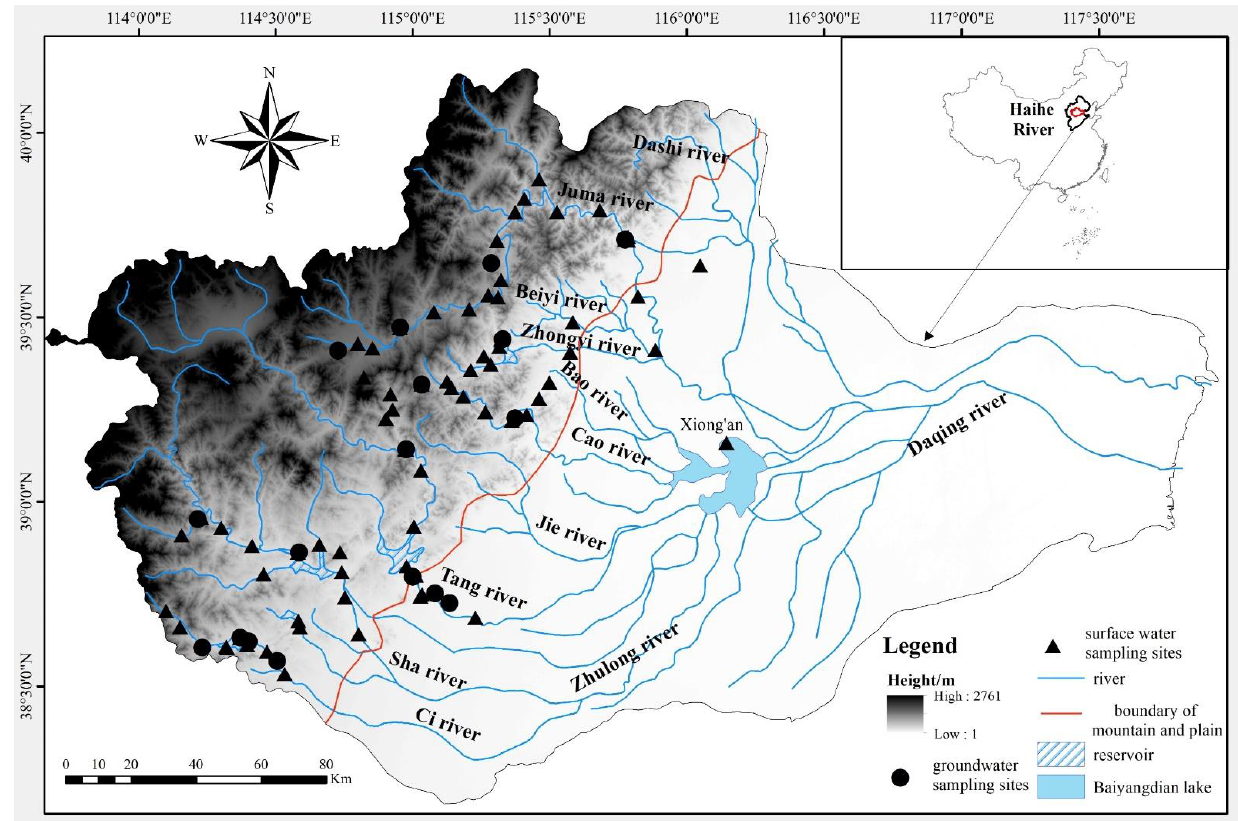
Figure 1. Distribution of water sample collection locations in the mountainous watershed of Daqing River.